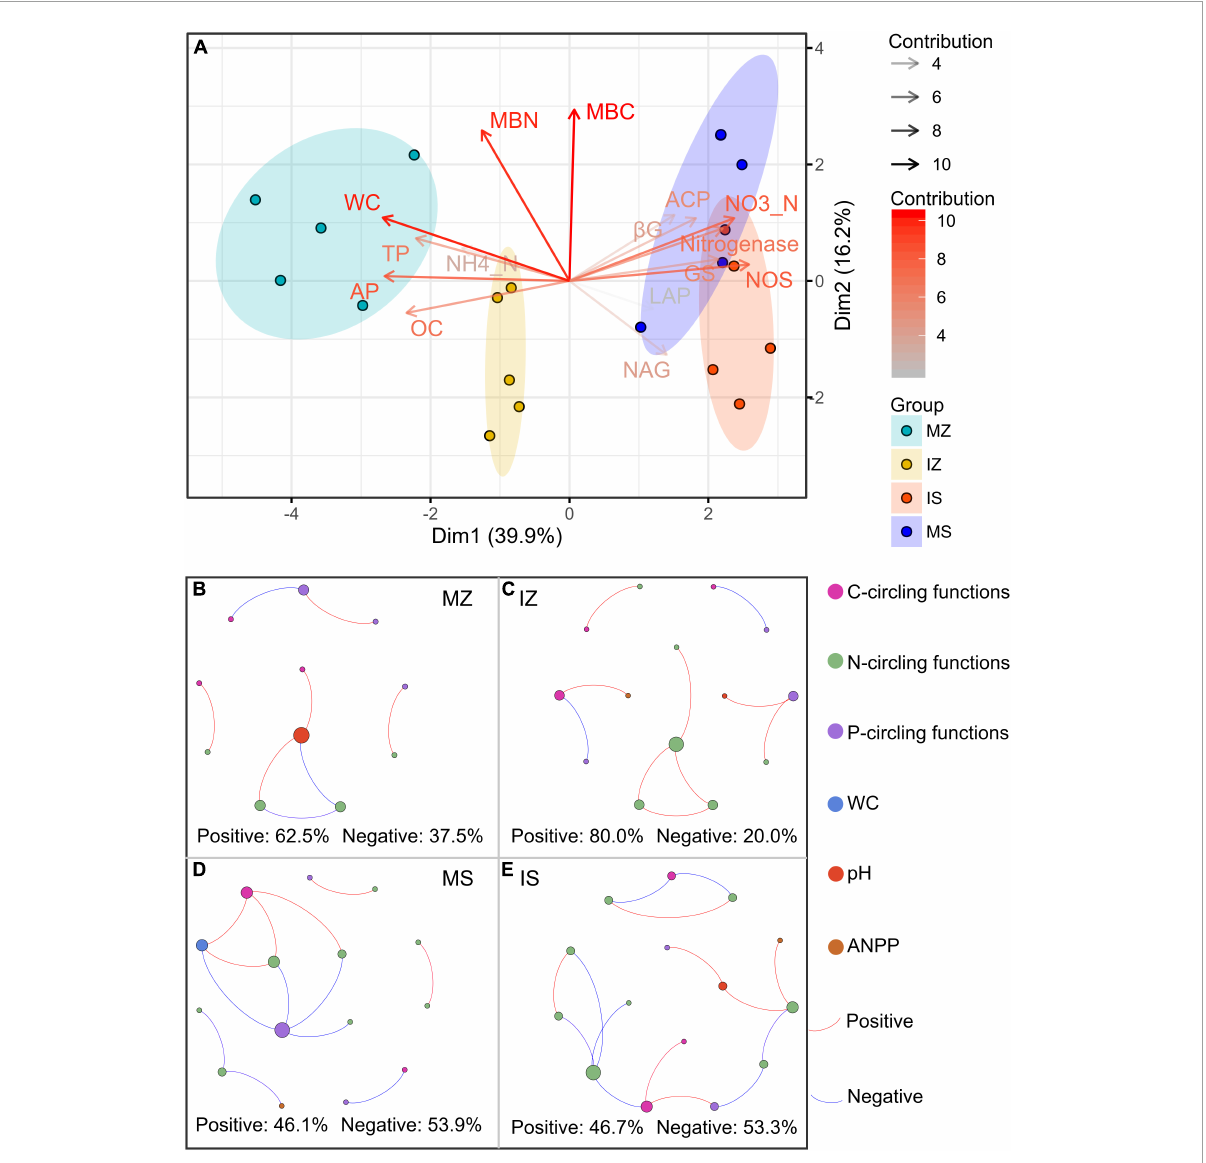
FIGURE2 (A) Principal component analysis of multiple rhizosphere functions and in the different groups, showing overall intuitive distribution of multiple functions and aboveground net primary productivity, and the contribution of each function to this distribution. (B–E) Relationships among individual rhizosphere functions and aboveground net primary productivity (ANPP). MZ, monoculture Zea mays ; IZ, intercropping Zea mays ; MS, monoculture Sophora davidii ; IZ, intercropping Sophora davidii